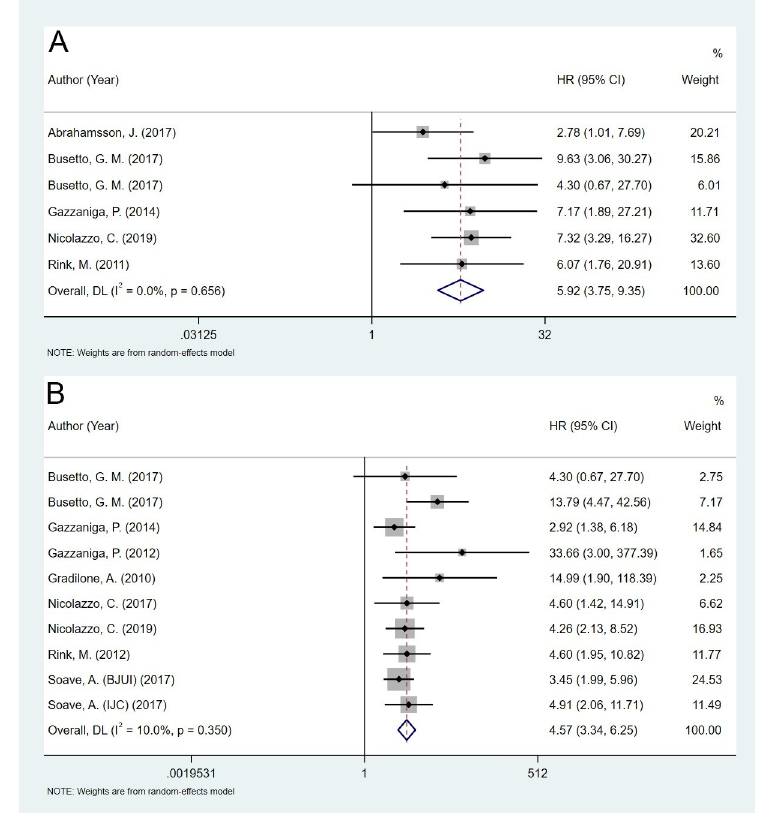
Fig 3. Pooled HRs for progression-free survival/time to progression and disease-free survival/recurrence-free survival/time to first recurrence of patients in the included studies. A: progression-free survival/time to progression. B: disease-free survival/recurrence-free survival/time to first recurrence.